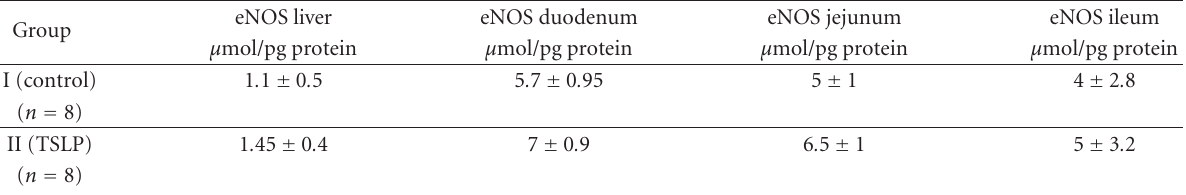
Table 4. Liver and intestinal endothelial nitric oxide synthase (eNOS) activity in control rats (Group I) and in rats with triple stenosing ligation of portal vein (TSLP) after 28 days of evolution. The results are represented as mean ± SD. Group